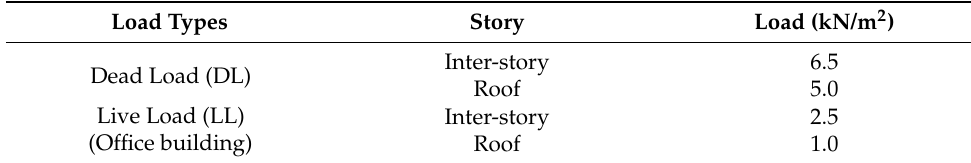
Table 1. Dead and live loads of the 3- and 7-story buildings.